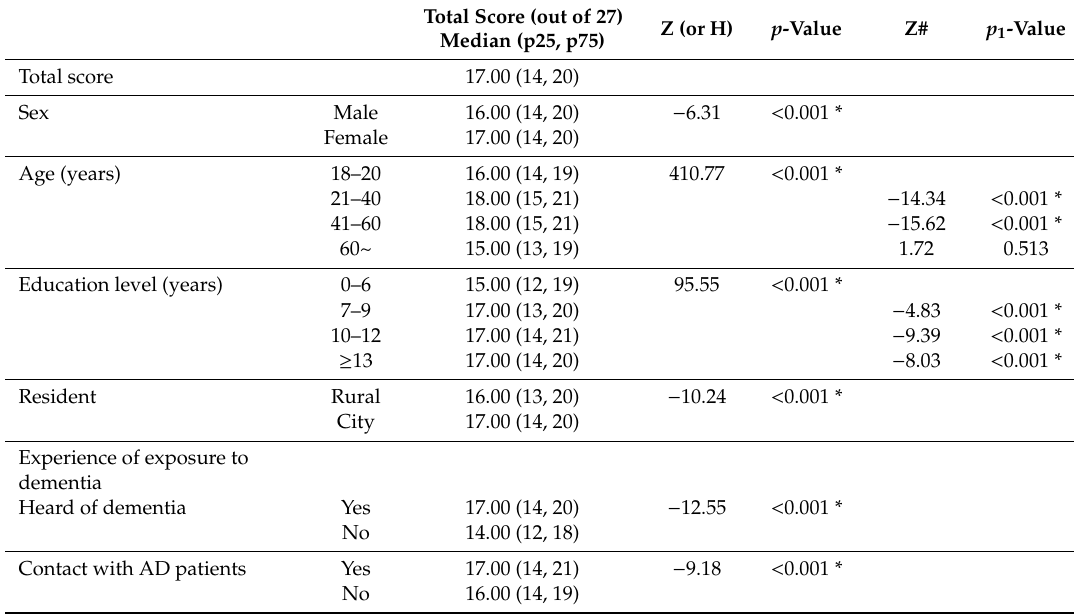
Table 3. Relationship between socio-demographic characteristics, experience of exposure to dementia, and knowledge about